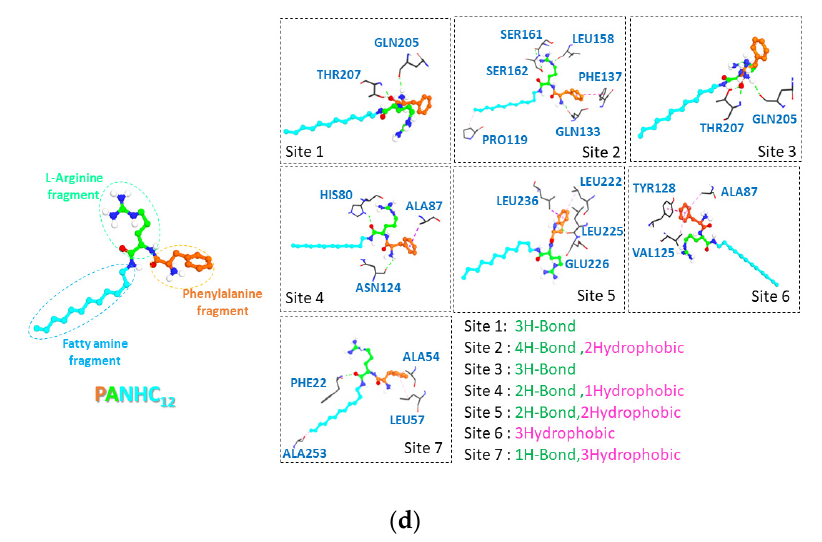
Figure 10. Different types of interaction on the surface of the zein structures (Q9SYT3_MAIZE) in different binding sites for ( a ) LAM, ( b ) PNHC 12 , ( c ) C 12 PAM and ( d ) PANHC 12.